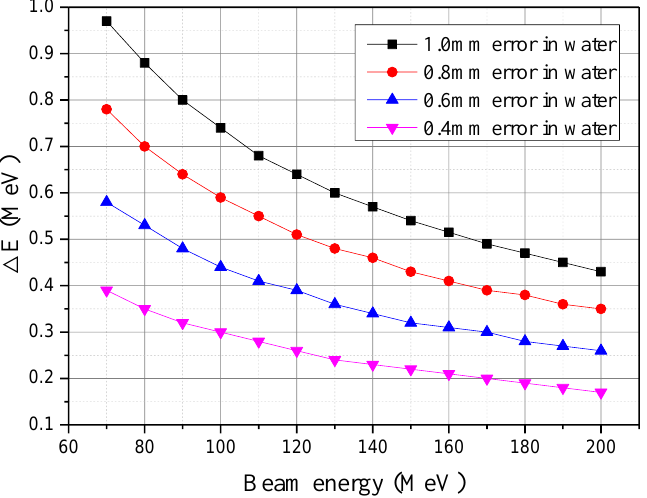
ff erence under di ff erent range errors in Figure 3. Energies difference under different range errors in water. Figure 3. Energies di